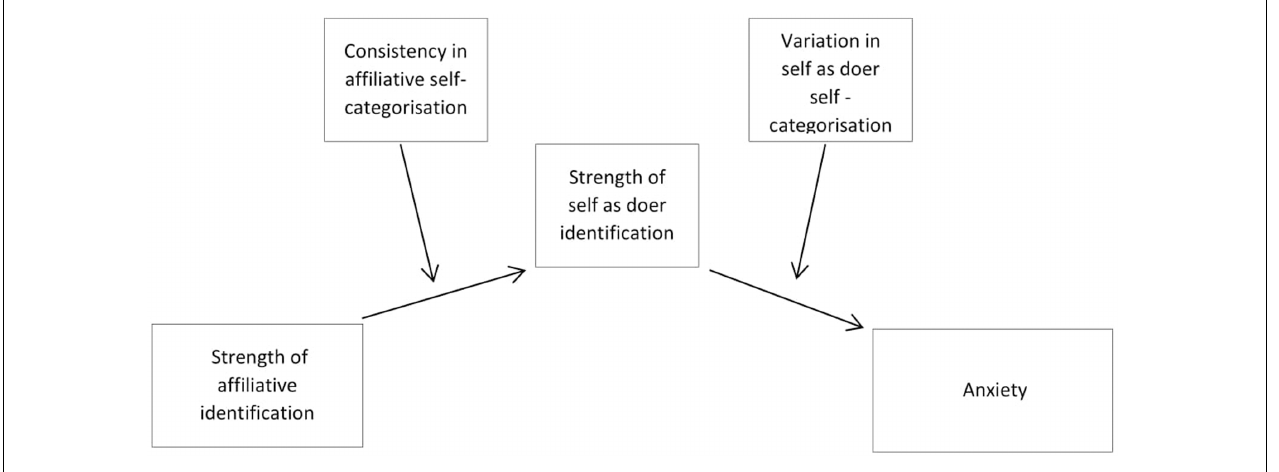
Similarly, with inconsistency in both affiliative and self as doer self-categorisations the indirect effect of strength of affiliative identification on anxiety was not significant: B = 0.04, SE =